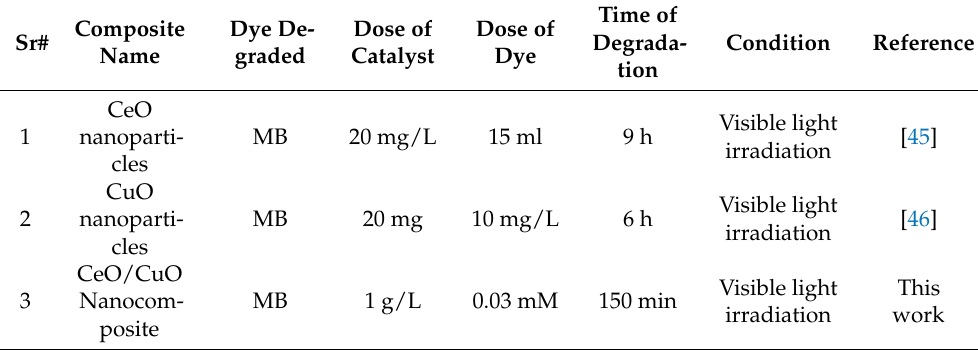
Table 1. Comparing catalysts performance of CeO, CuO, and CeO/CuO nanocomposite.